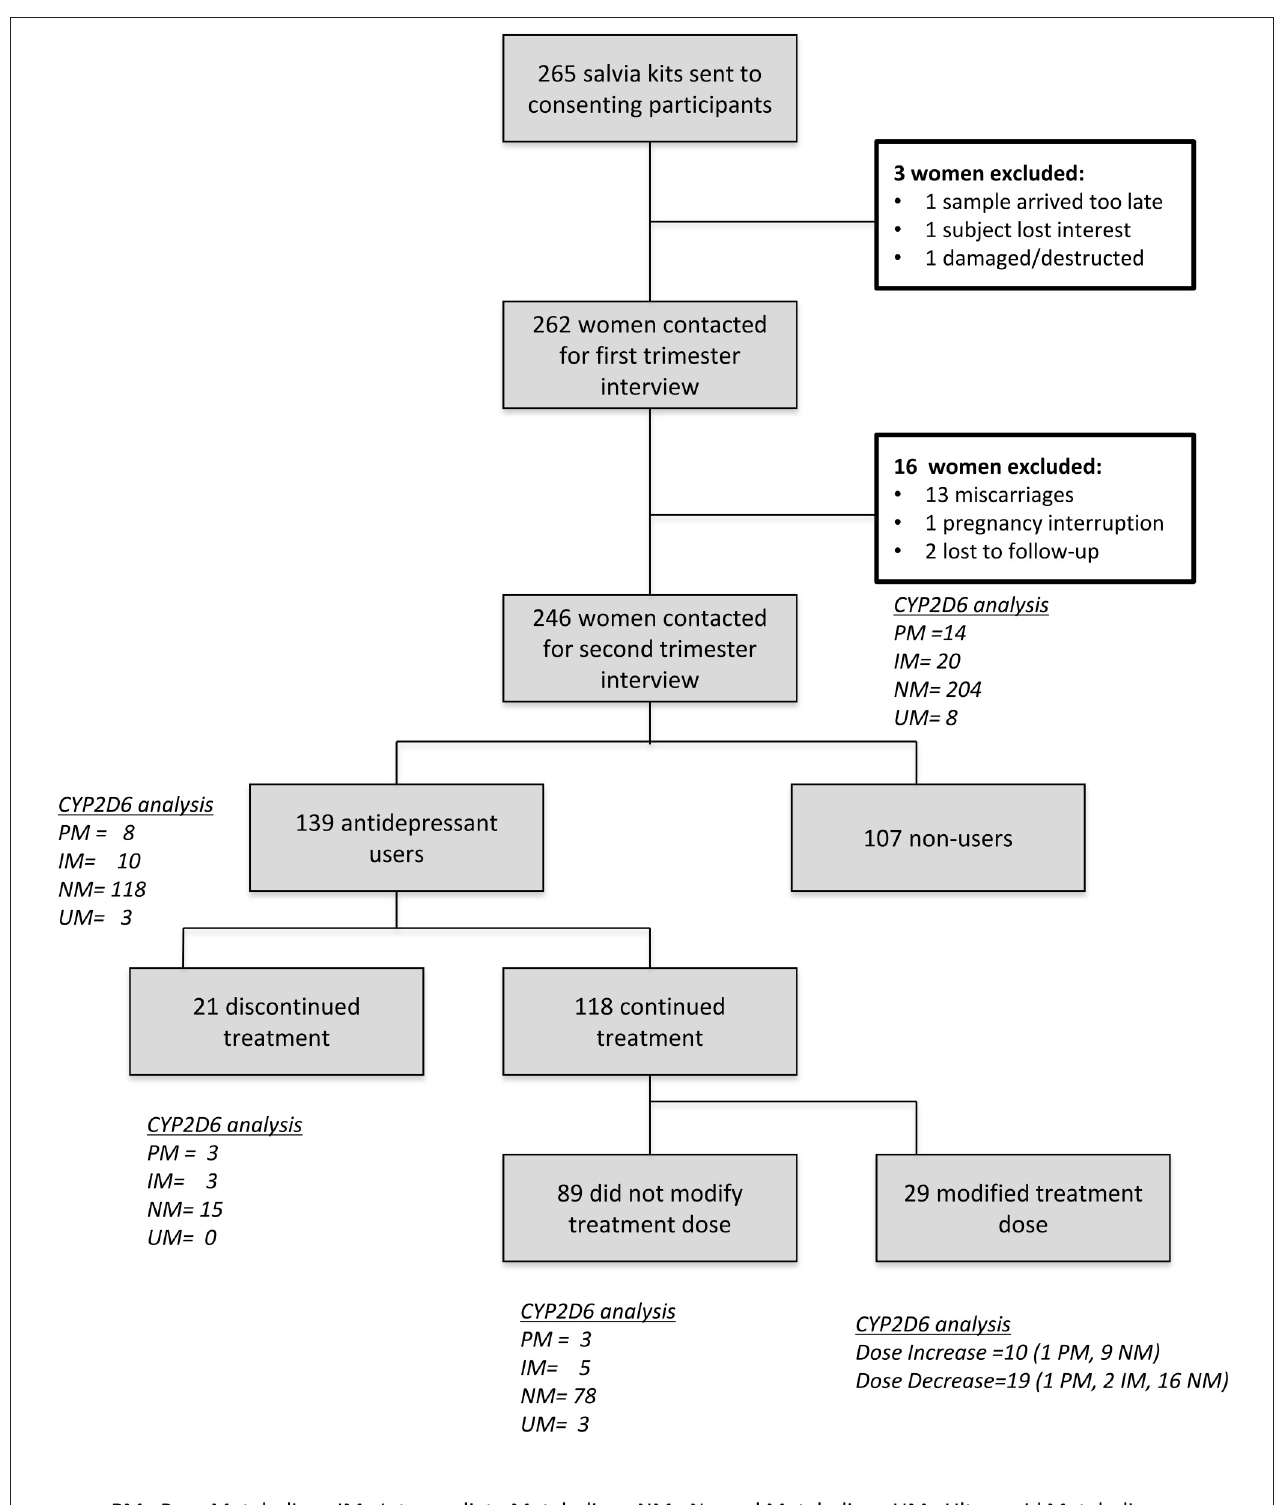
FIGURE 1 | Patient recruitment flow-chart and CYP2D6 predicted phenotypes.